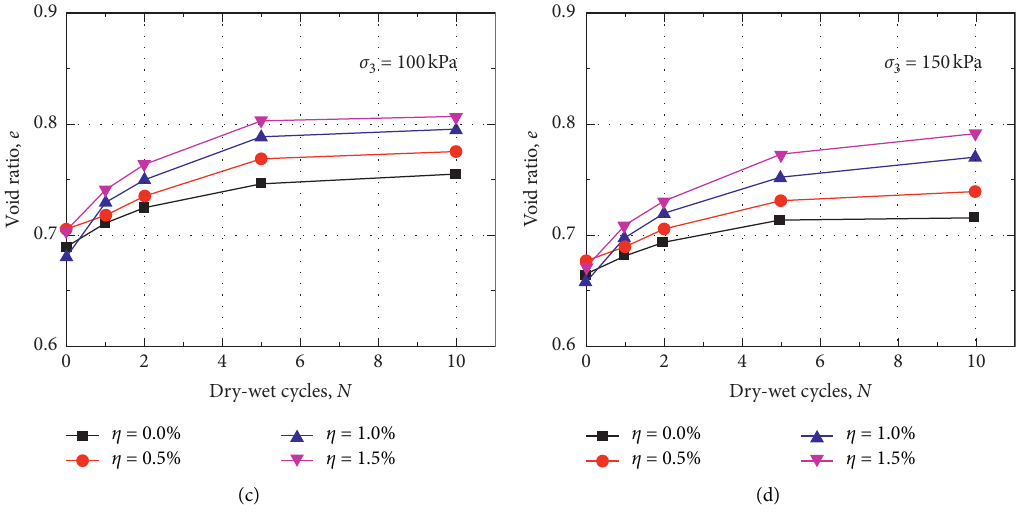
Figure 7: The void ratio of saline intact loess after dry-wet cycles.